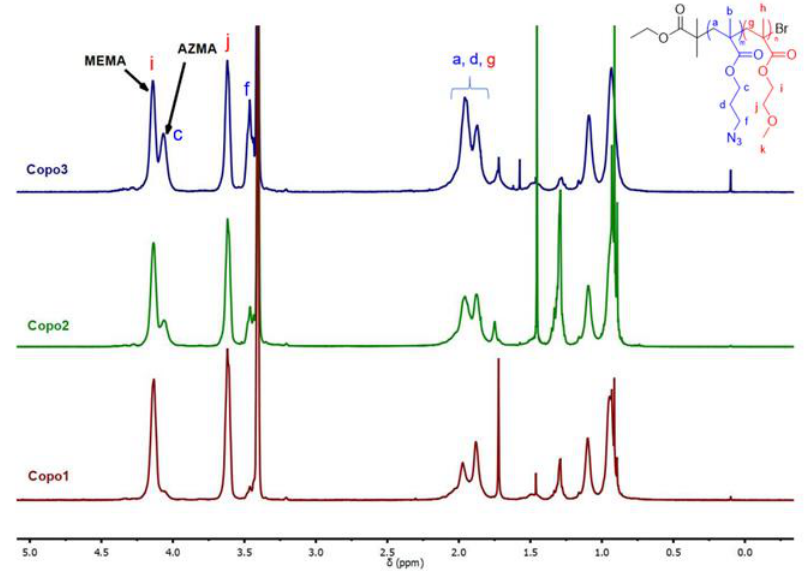
Figure 3. NMR spectra of copolymers.